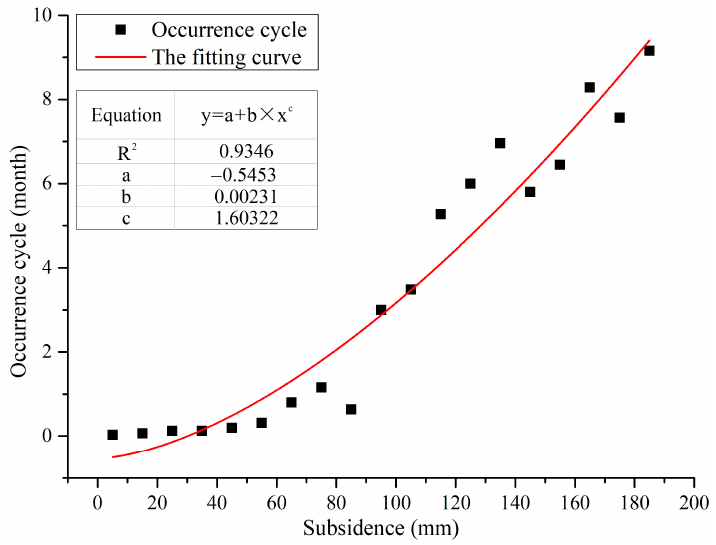
Figure 4. Power-law relationship between the subsidence and its occurrence